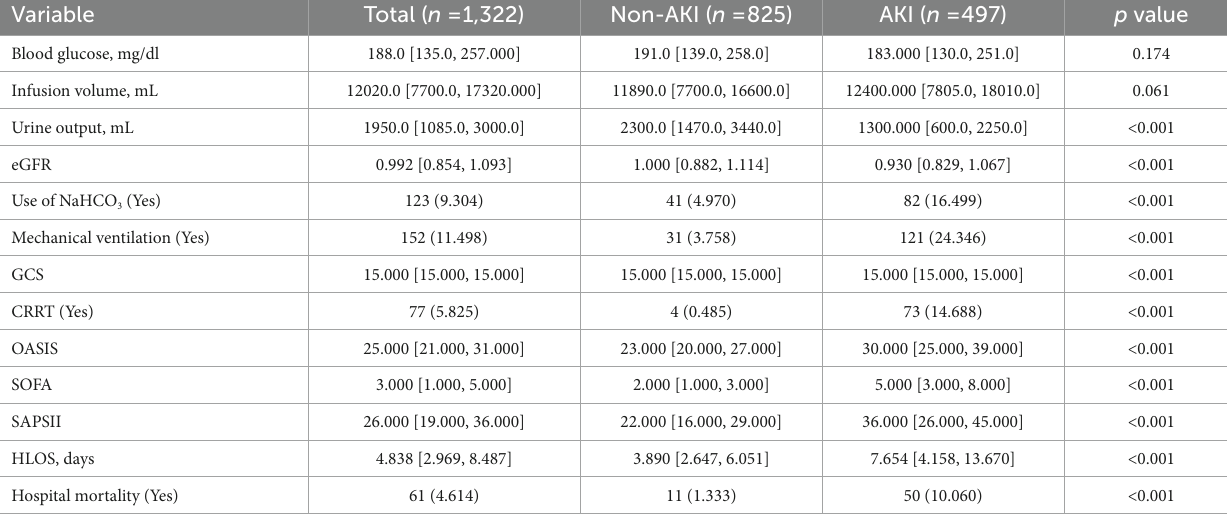
0.716, a specificity of 0.823, and an accuracy of 0.782 in the training set (Table 2). When internal validation was performed, the XGBoost model still showed optimal performance with an AUC of 0.800